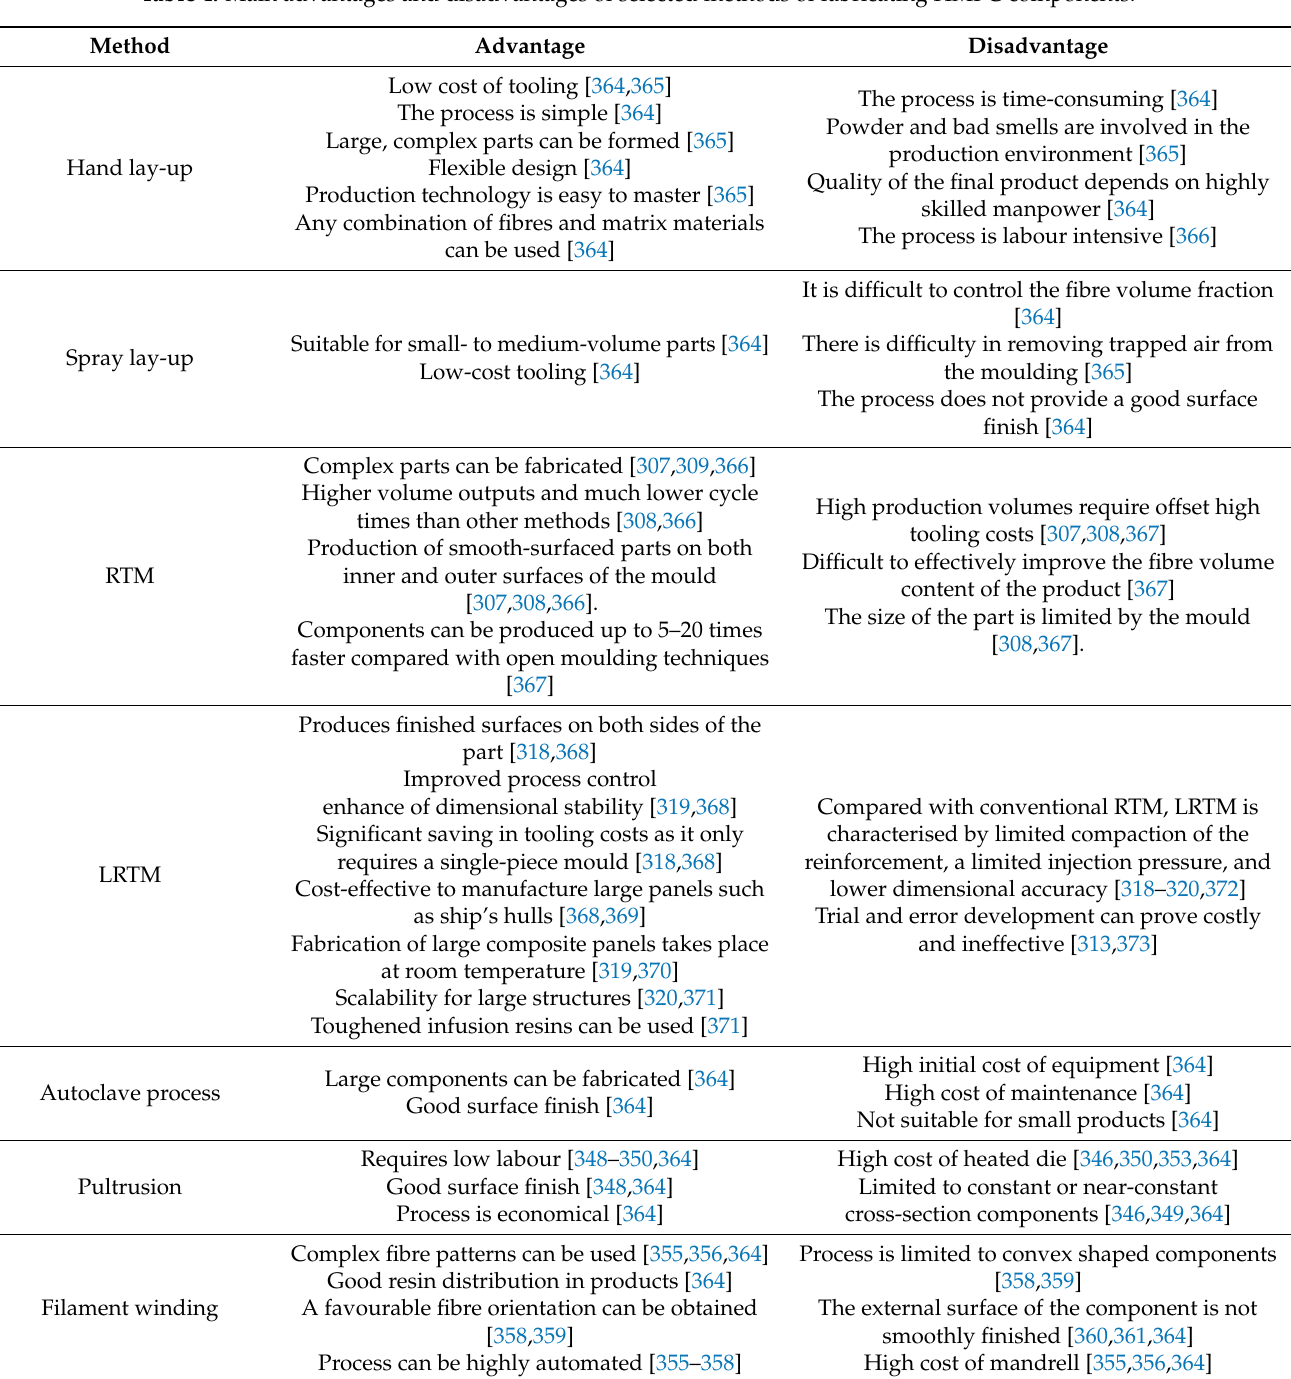
Table 4. Main advantages and disadvantages of selected methods of fabricating HMPC